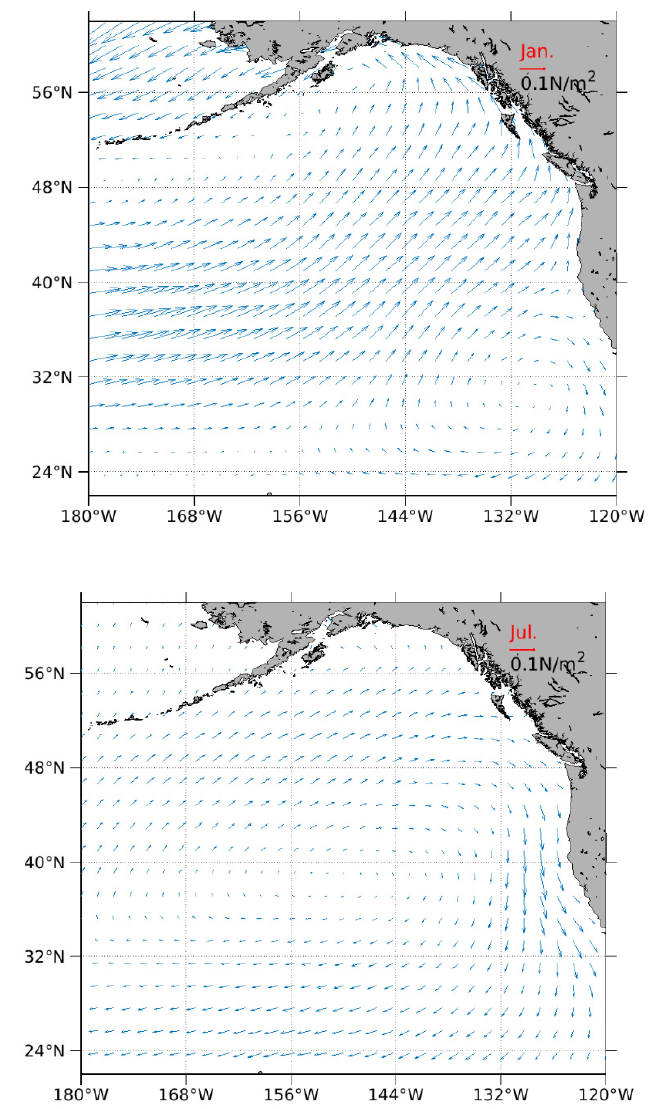
Figure 12. Climatological monthly wind stress distribution in January and July. Data are from NCEP.